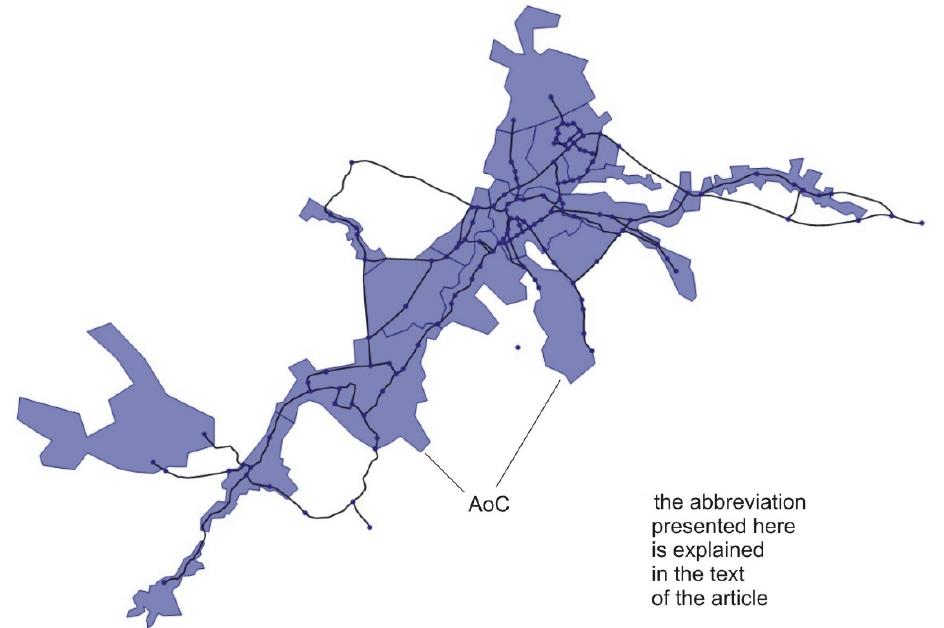
Figure 8. The model for case 4: Collecting data for traffic modeling.